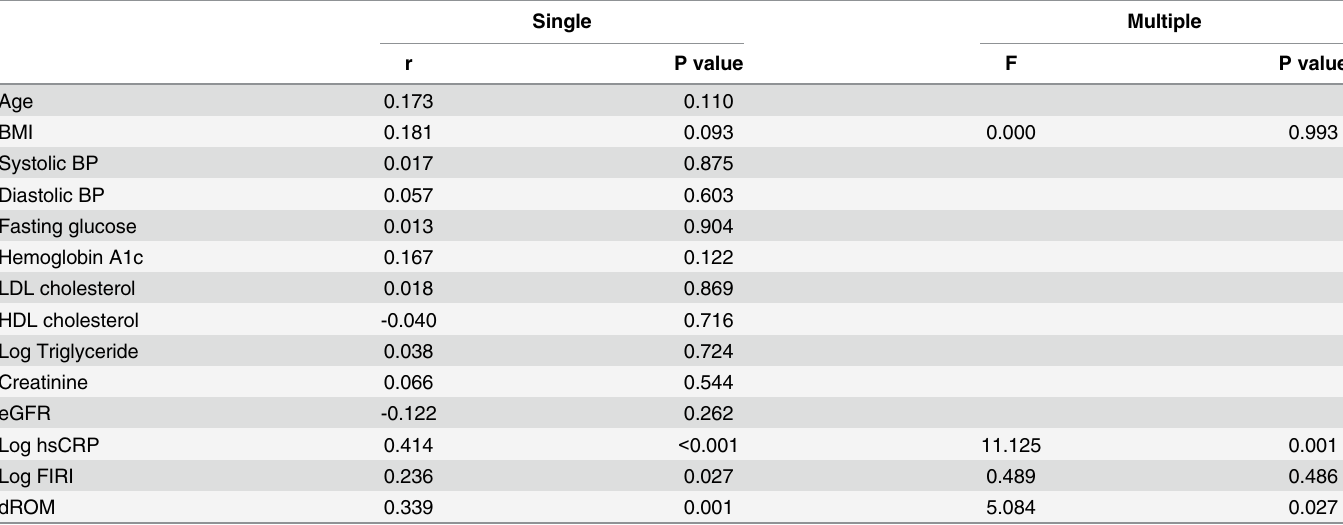
Table 2. Correlation with Log Fstl1 levels.